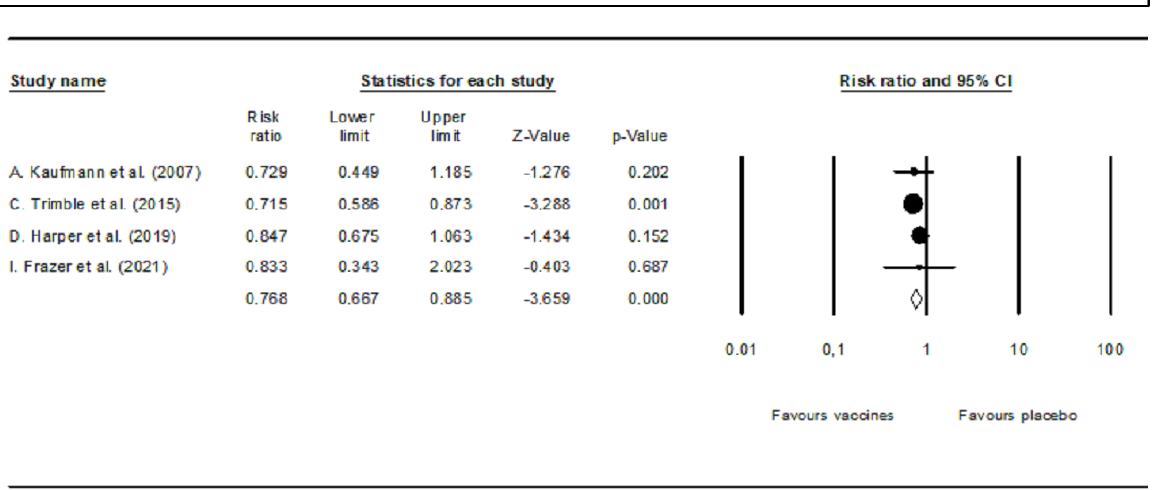
Figure 6. Forest plot of DNA clearance after vaccination compared with placebo. PCR amplification was utilized to assess HPV DNA in cervical biopsies.